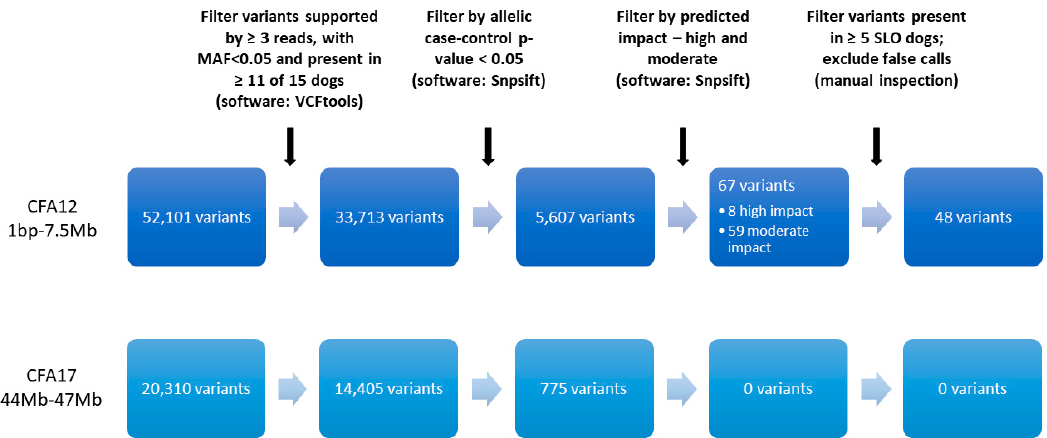
Figure 2. Filtering process of whole genome sequence variants identified within the GWAS regions of association on canine chromosomes (CFA) 12 and 17 for further exploration of their association with symmetrical lupoid onychodystrophy (SLO) in Bearded Collies. Chromosome locations are based on the CanFam3.1 reference genome. Software used in each step indicated in